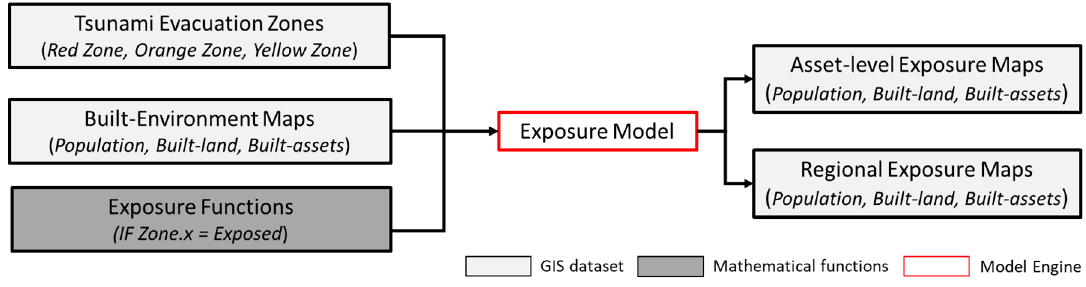
Figure 2. Schematic representation of the RiskScape exposure model framework and workflow applied in this study.